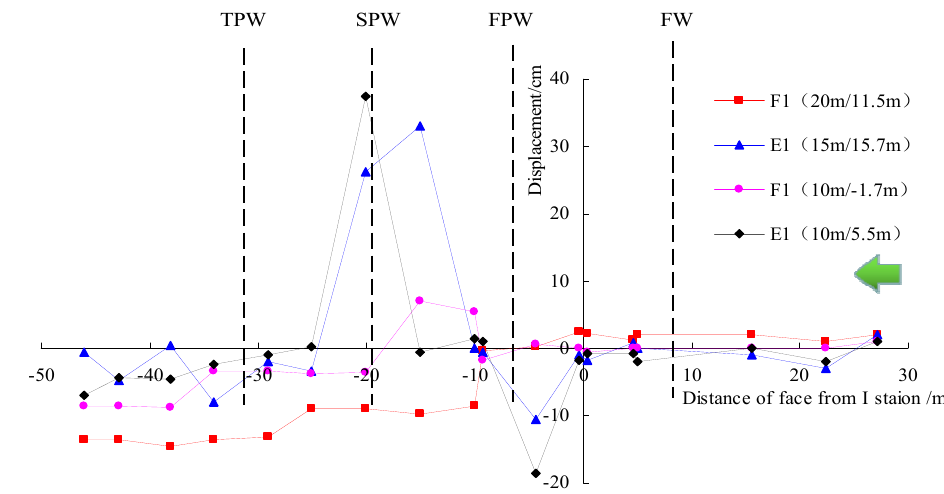
Figure 18. Displacement of the E and F drillholes at the I station.